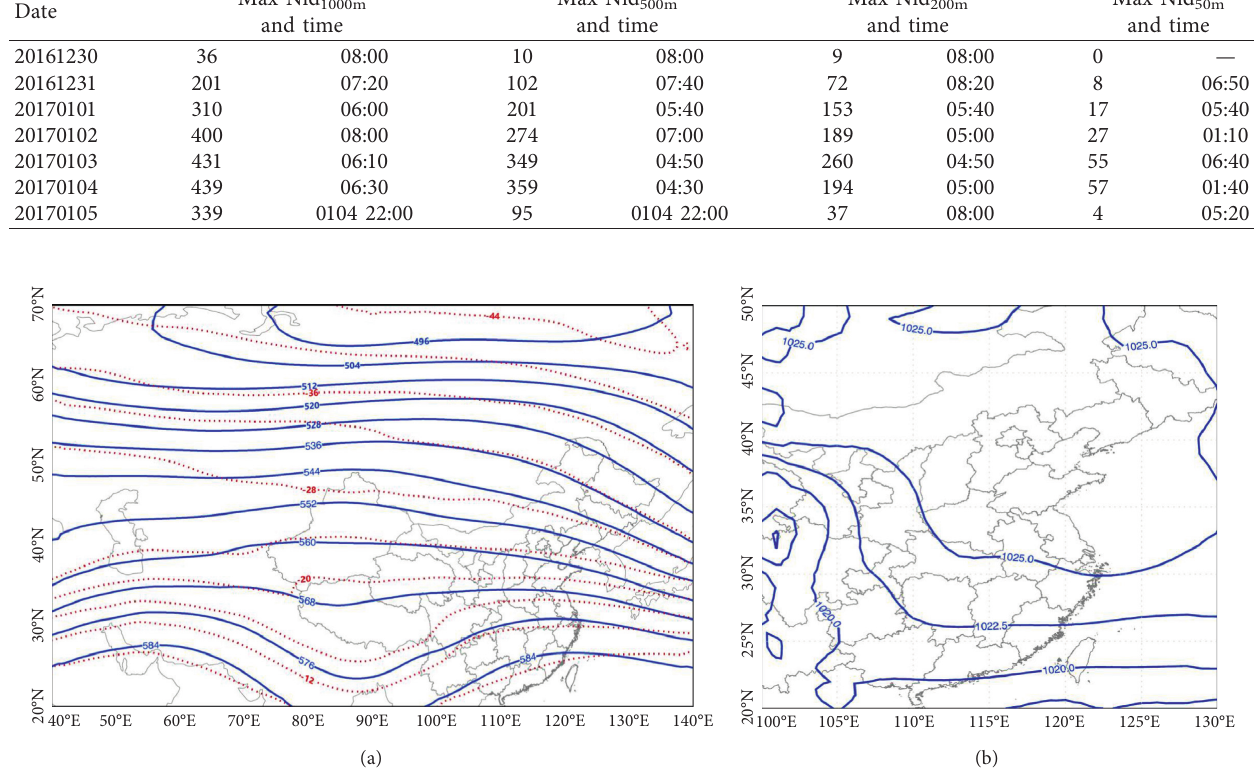
Figure 4: The 500hPa mean geopotential height (unit: dagpm) and temperature field (unit: ° C) (a) and mean sea level pressure field (unit: hPa) (b) from December 30, 2016, to January 5, 2017.